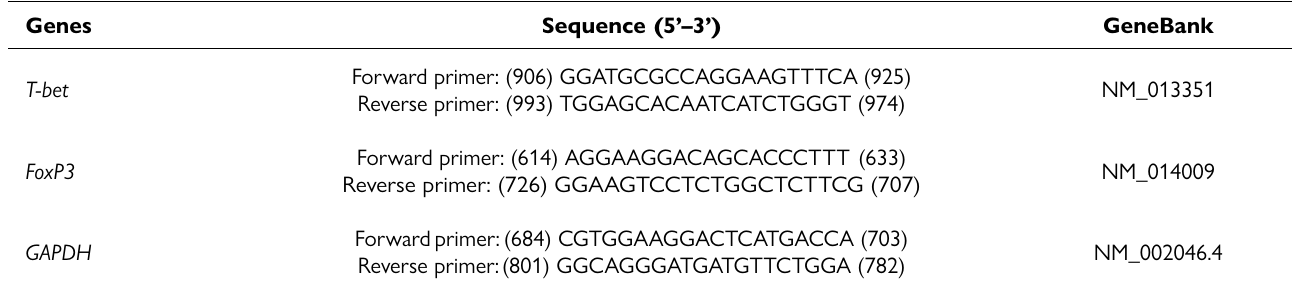
Table 1. Sequence of primers for the transcription factors and